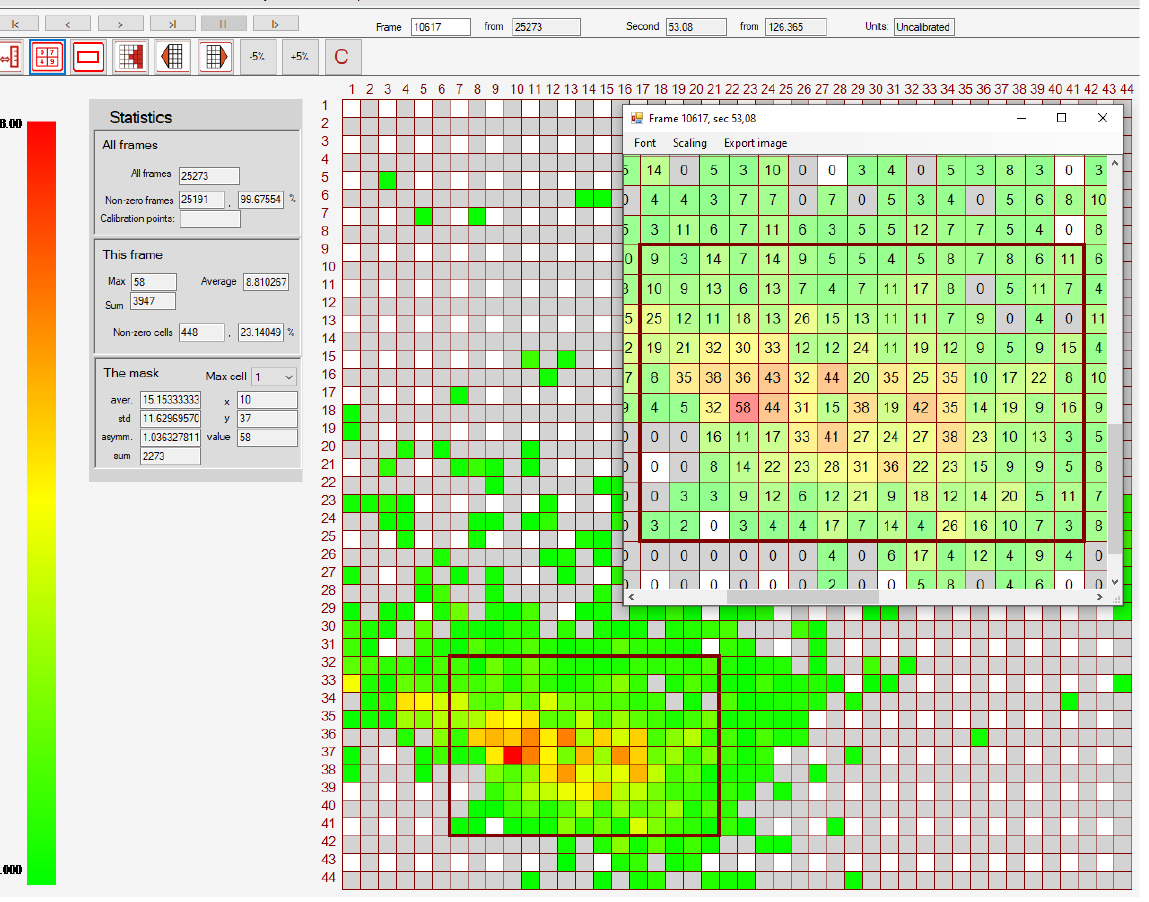
Figure 6. High pressure zone patch on Sensor1 caused by model ice in the ice tank experiment (in raw units). The color legend for raw pressure values is provided in the left part of the figure.